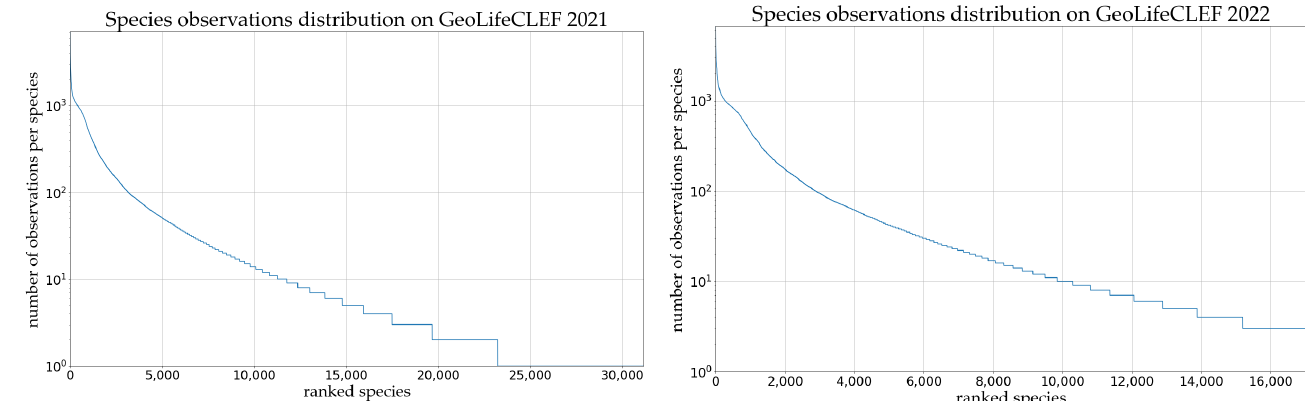
Figure 6. The species observation distribution of the GeoLifeCLEF 2021 and 2022 datasets.